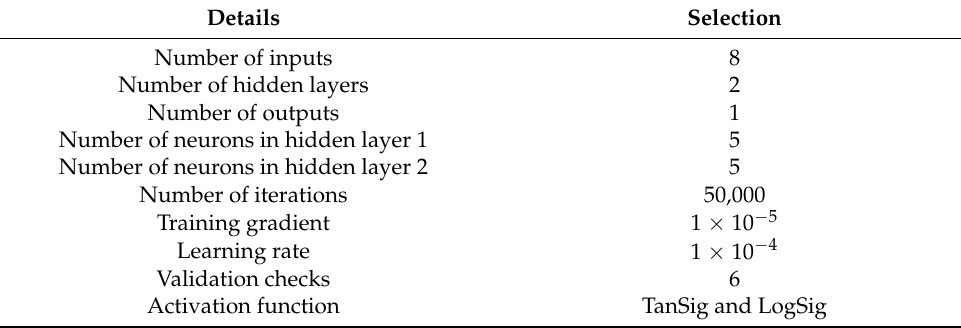
Table 9. The technical parameters of the